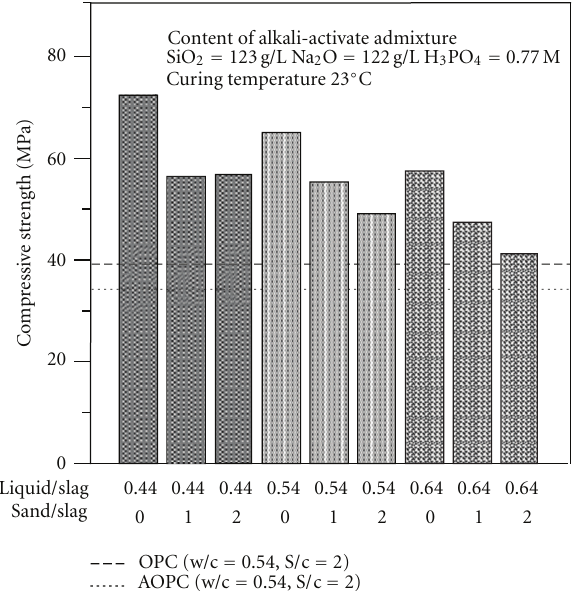
Figure 4: Compressive strength of AAS mortars at the age of 56 days.